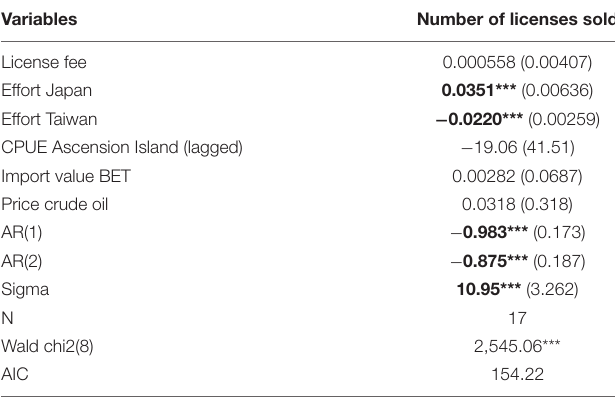
TABLE 2 | Results of an AR(2) estimation model explaining the number of licenses sold (1988 – 2016).